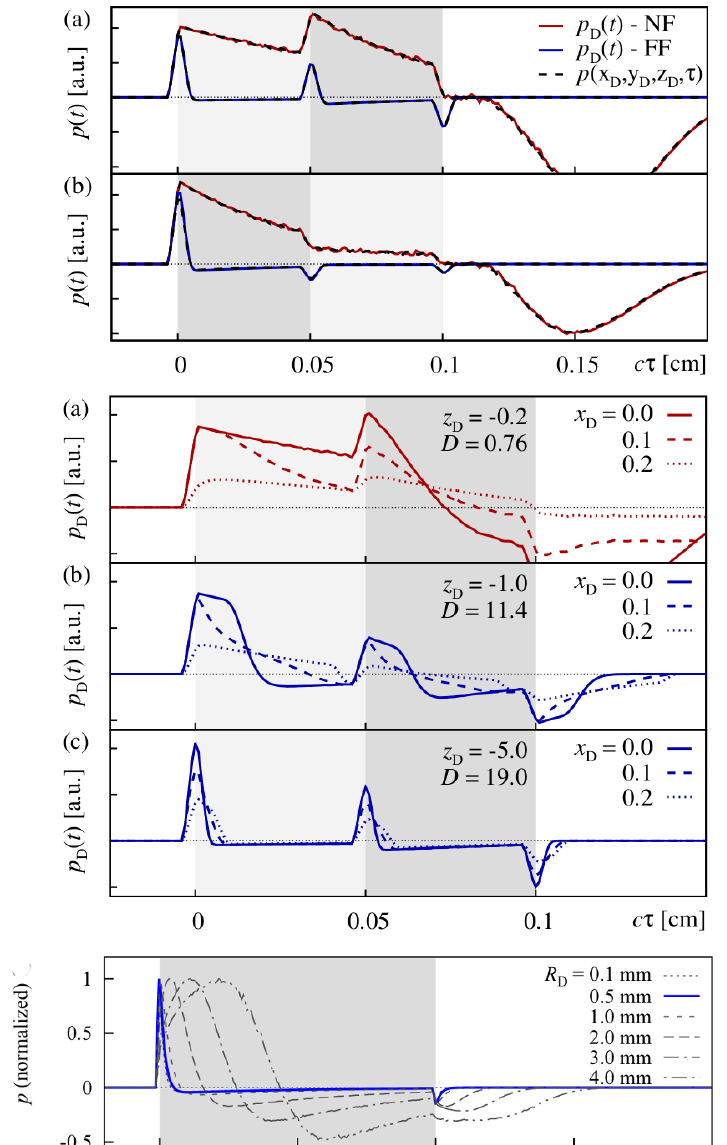
Figure 18. Influence of geometrical factors in the detector setup on measured optoacoustic signal. Gray shadings mark optically absorbing layers of different relative strength. The top panel shows a comparison of different solvers for the optoacoustic problem for layered media in two reversed layer scenarios (a and b). The measured signal p D ( t ) is shown in the acoustic near-field (NF) at a distance z of 0.04 cm between sample and detector and for far-field (FF) conditions at z = 4.0 cm (reproduced with permission from [106]). Calculations refer to detection on the illumination beam axis while the middle panel shows how the signal deforms upon displacement x of the detector off the beam axis for NF (a) to FF (c) conditions (reproduced with permission from [106]). The bottom panel shows the effect of the detector size (detector radius R D ) for an optoacoustic signal in the far field (reproduced with permission from